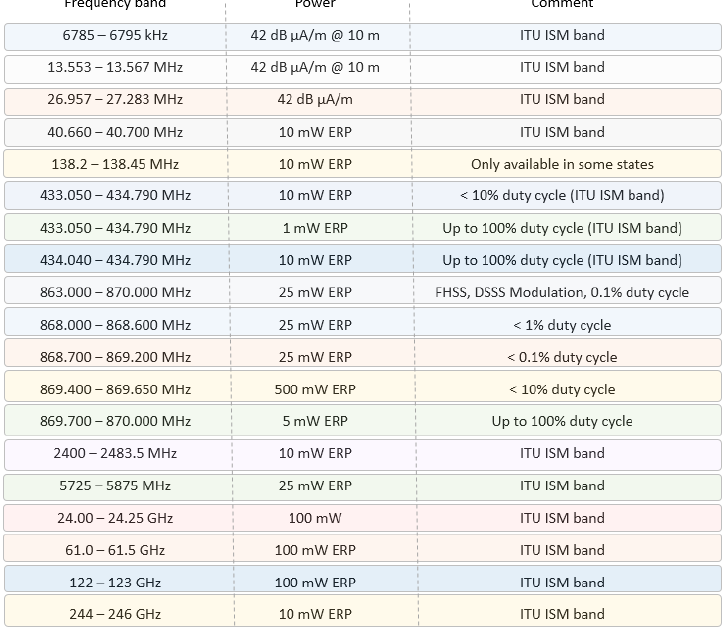
Figure 1. RFID standards for short distance applications